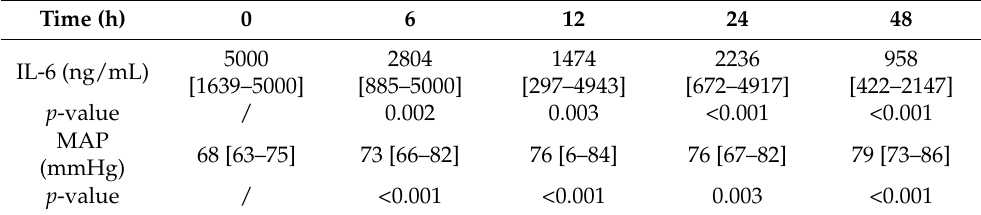
Figure 4. Hemodynamic and laboratory parameters from the beginning of CytoSorb treatment to 48 h after the start of the first CytoSorb treatment in a subgroup of patients with septic shock. Values presented as median and interquartile range, comparison by paired Wilcoxon test, * p < 0.012 was considered statistically significant. MAP—mean arterial pressure, VIS—vasoactive-inotropic score, PCT—procalcitonin, ns—not significant. Table 4. Hemodynamic and laboratory parameters from the beginning of CytoSorb treatment to 48 h after the start of the first CytoSorb treatment in a subgroup of patients with septic shock. Values presented as median and interquartile range, statistical comparison to time 0.